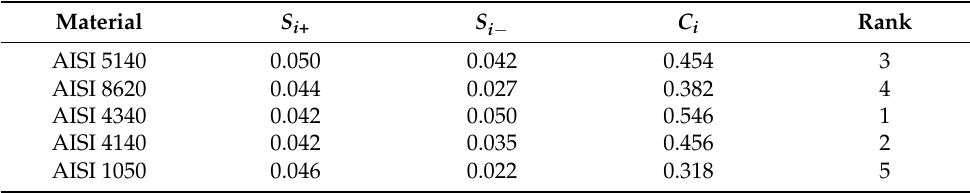
Table A7. TOPSIS rank result (AHP).